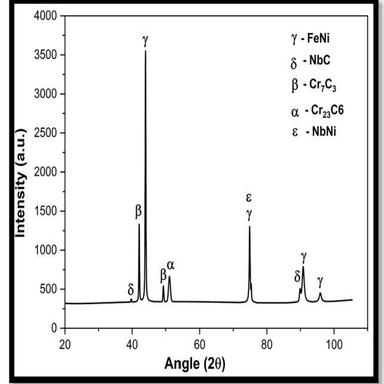
XRD pattern of weld joint.